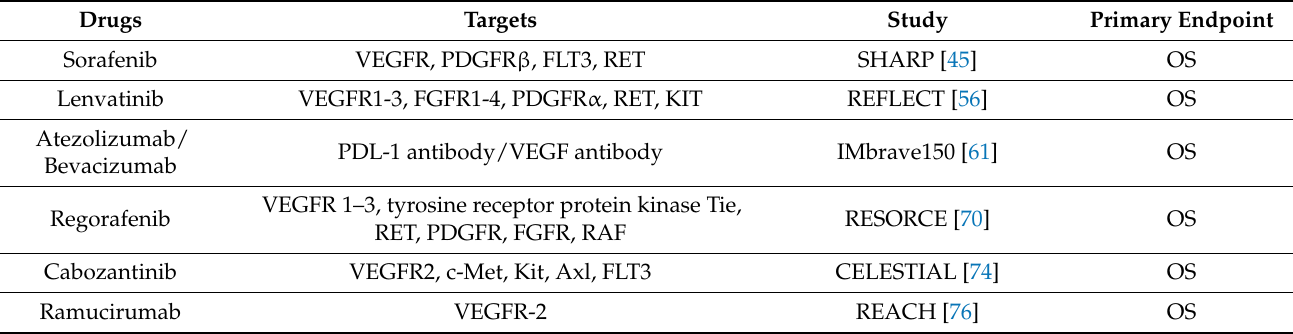
Table 1. The first and second line of therapy of HCC (Phase III